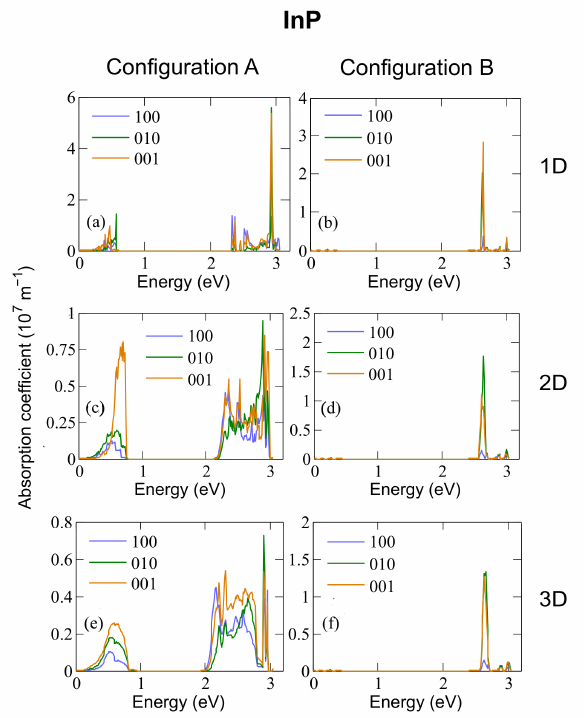
Figure 5. Absorption coefficient calculated at 300 K for 1D ( a , b ), 2D ( c , d ) and 3D ( e , f ) arrays of InP dots with radius R = 11.9 Å and either anion-rich (configuration A, left panels) or cation-rich (configuration B, right panels) surfaces.